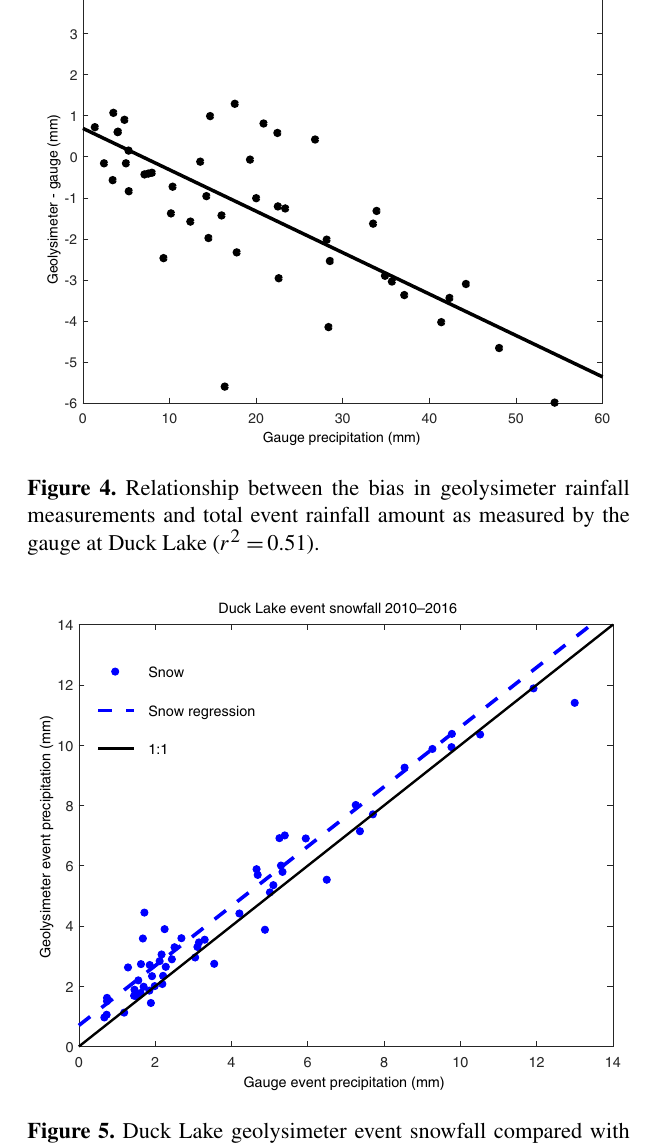
Figure 5. Duck Lake geolysimeter event snowfall compared with gauge event snowfall. Regression line for snow and the 1:1 line are also